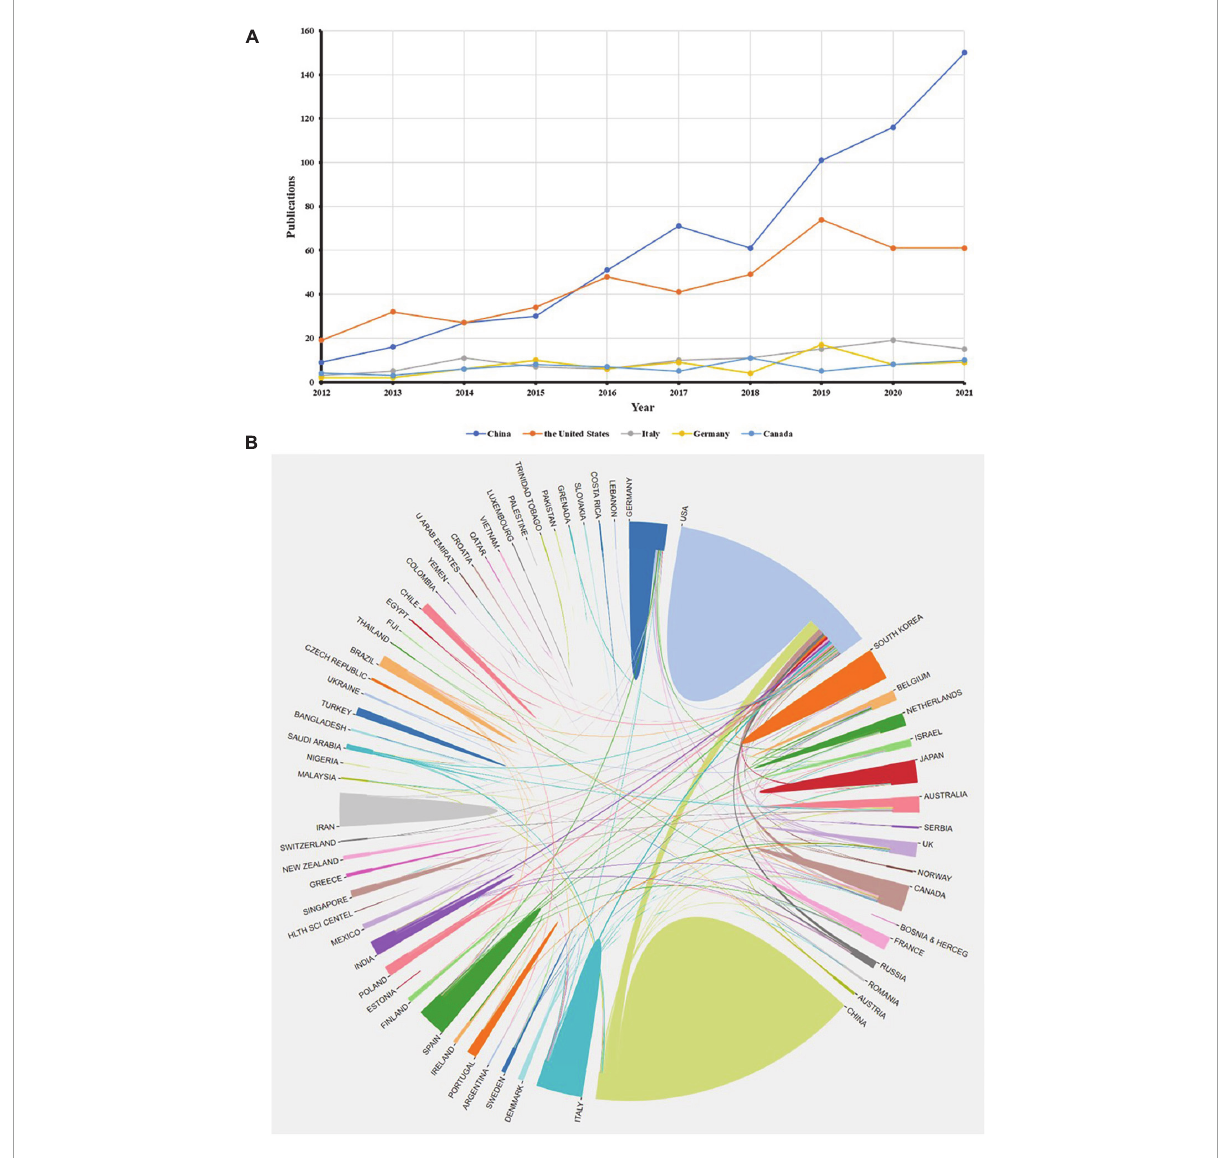
FIGURE3 Countries/regions analysis in the field of AD and ncRNAs in the past decade. (A) The annual publications of the top five countries. (B) Cooperation among countries/regions in the